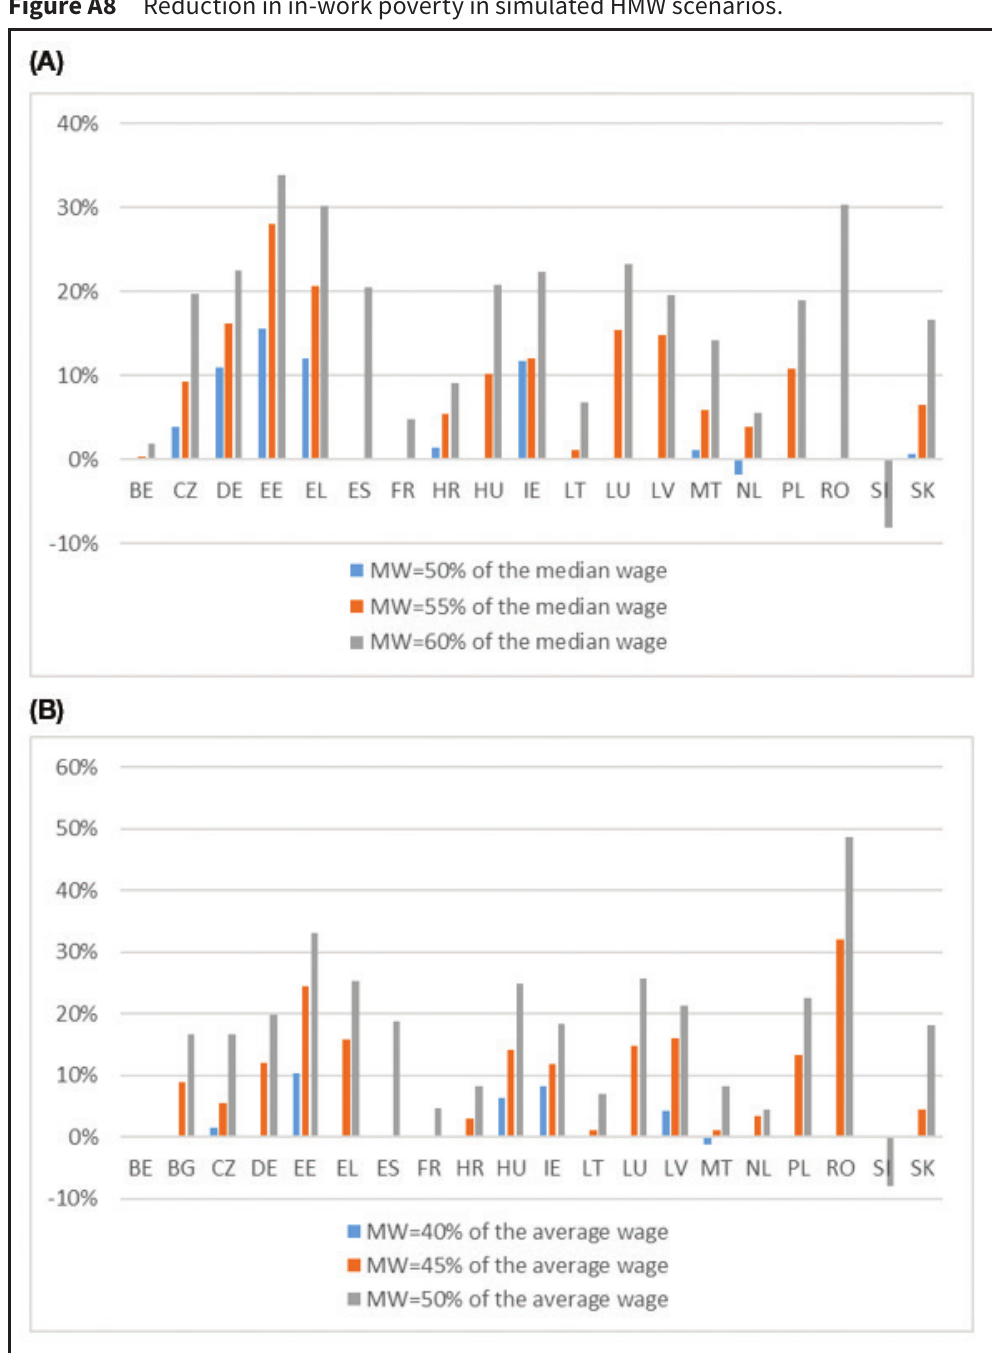
Figure A8 Reduction in in-work poverty in simulated HMW